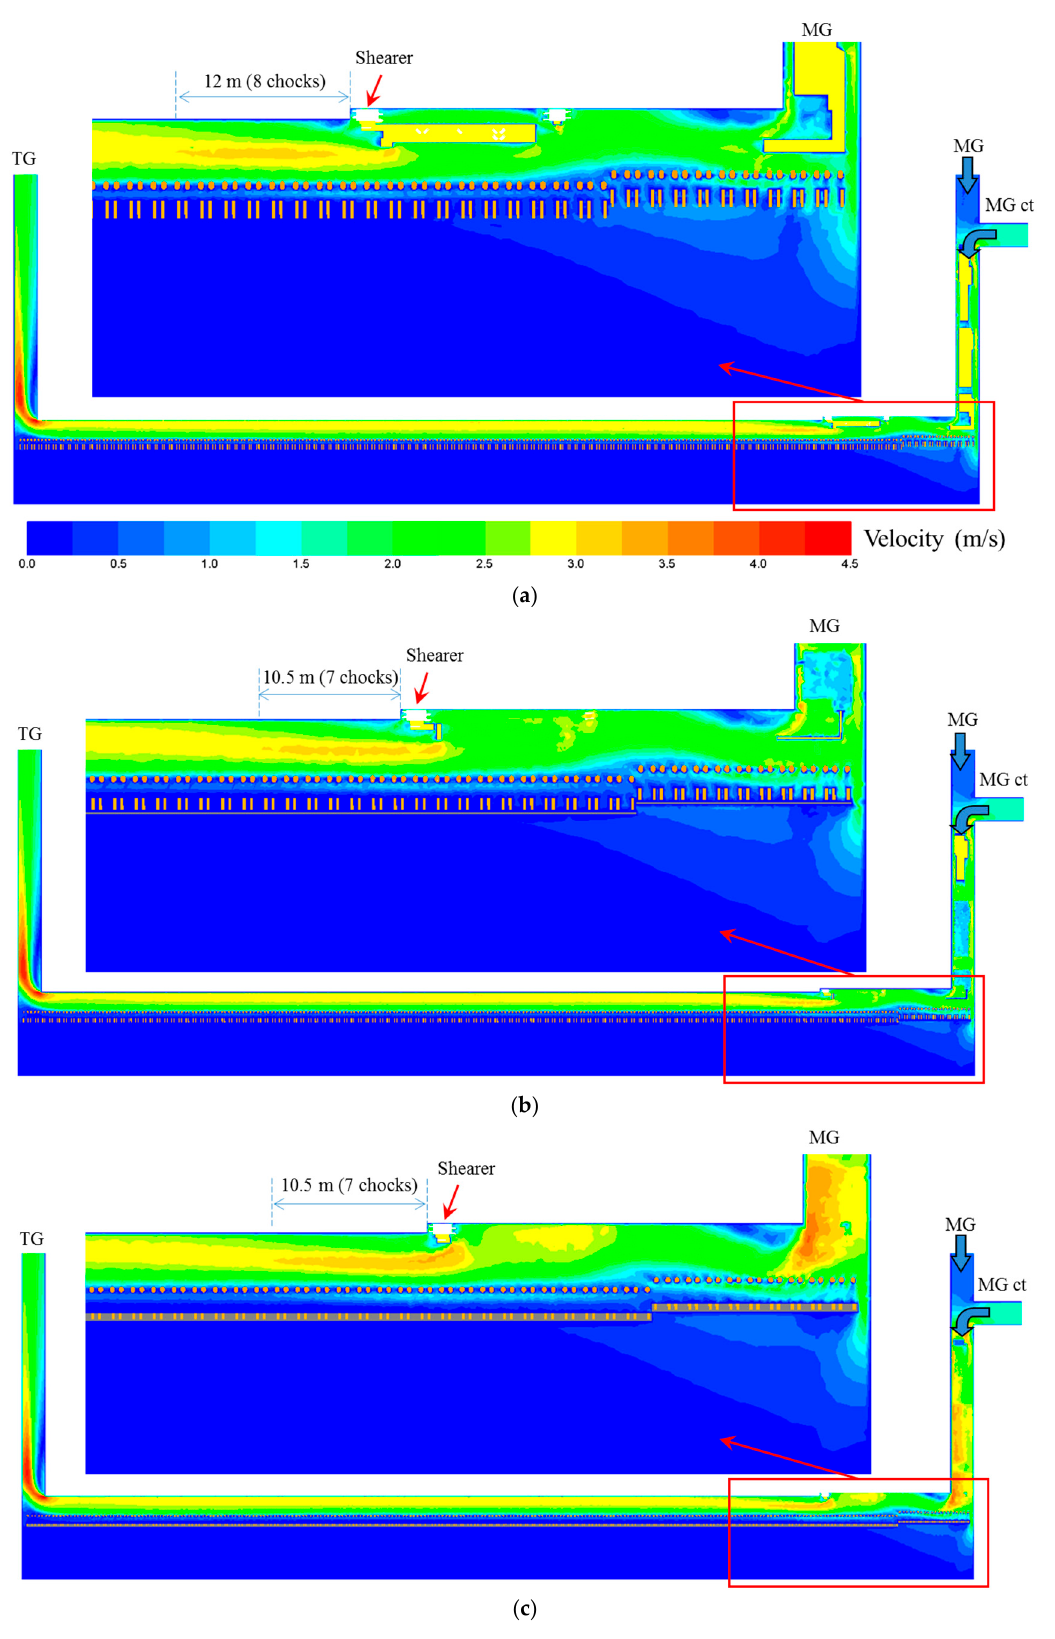
Figure 5. Cont. Figure 5.